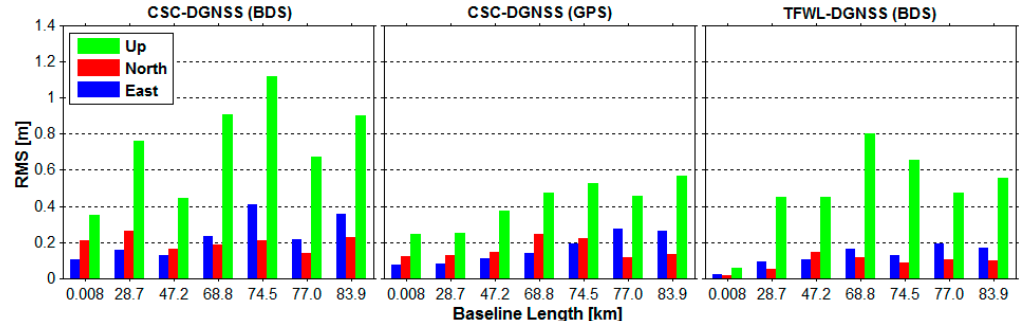
Figure 7. RMS of the positioning errors versus the baseline length. The left panel is for CSC-DGNSS results derived from BDS observations, the middle panel is for CSC-DGNSS results derived from GPS observations whereas the right panel is for TFWL-DGNSS results derived from BDS observations.